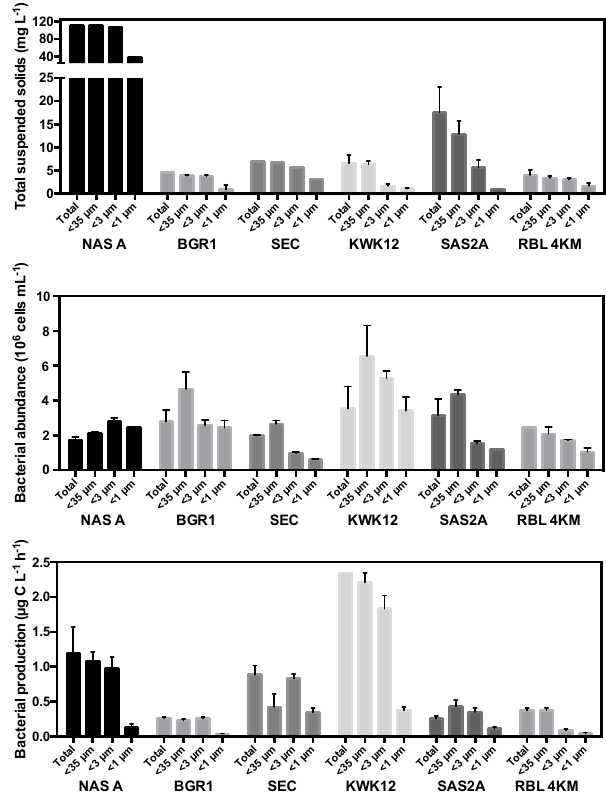
Figure 6. Size-fractionated total suspended solids (TSS), bacte- rial abundance (BA), bacterial production (BP), and bacterial cell- specific growth rates (BG) from five thermokarst lakes and one rock-basin lake. Each is the mean ± SD of triplicate samples.